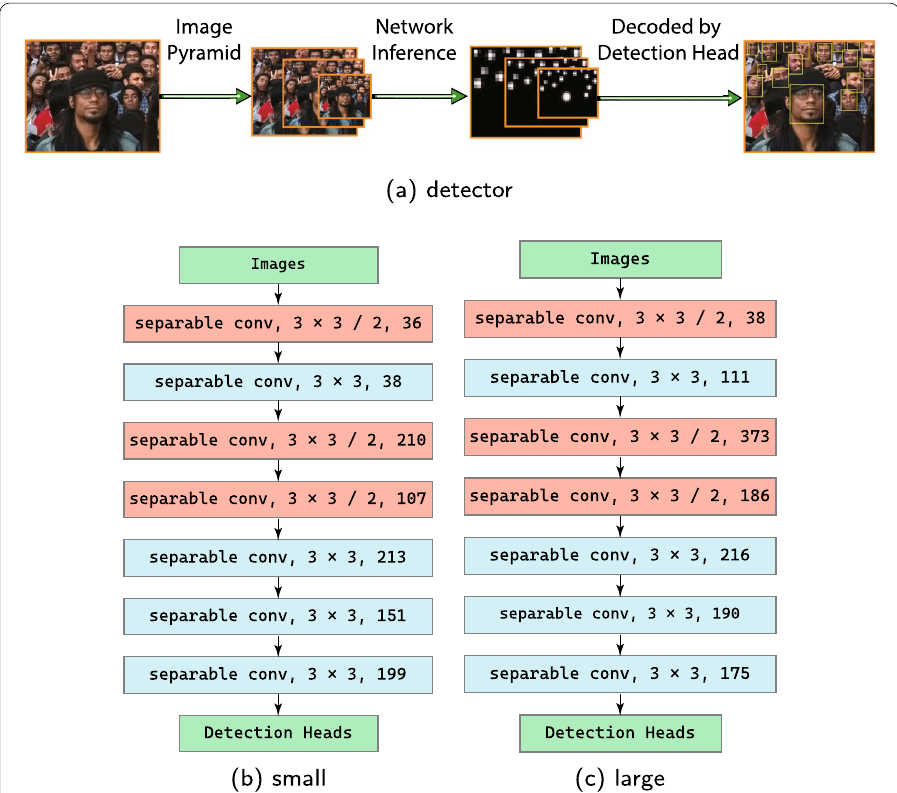
Fig. 3 Face detector Inference structure. a The detector is composed of three parts, preprocess, network, and postprocess. b and c are the searched network structure. “/2” means the convolution’s stride is